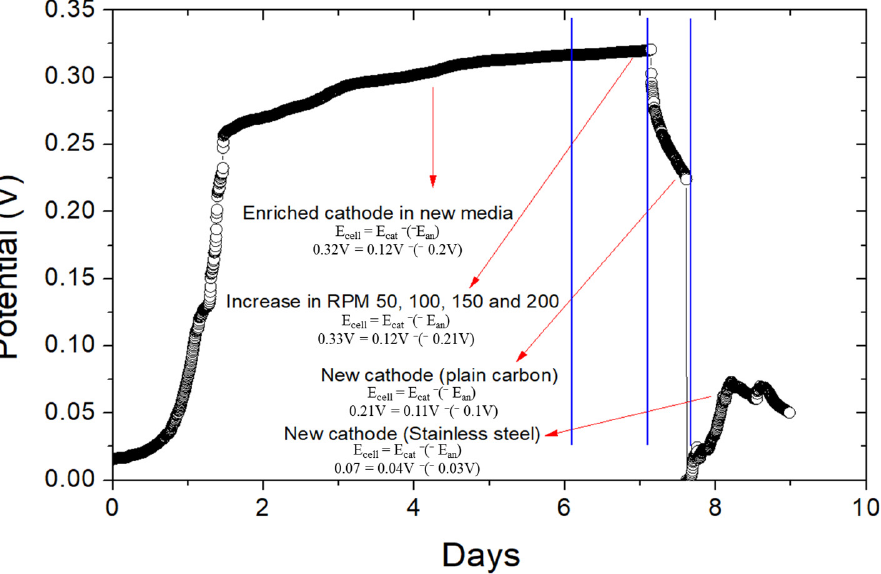
Figure 5. Potential observed in the MFC with fresh GAC particles and different cathode systems.